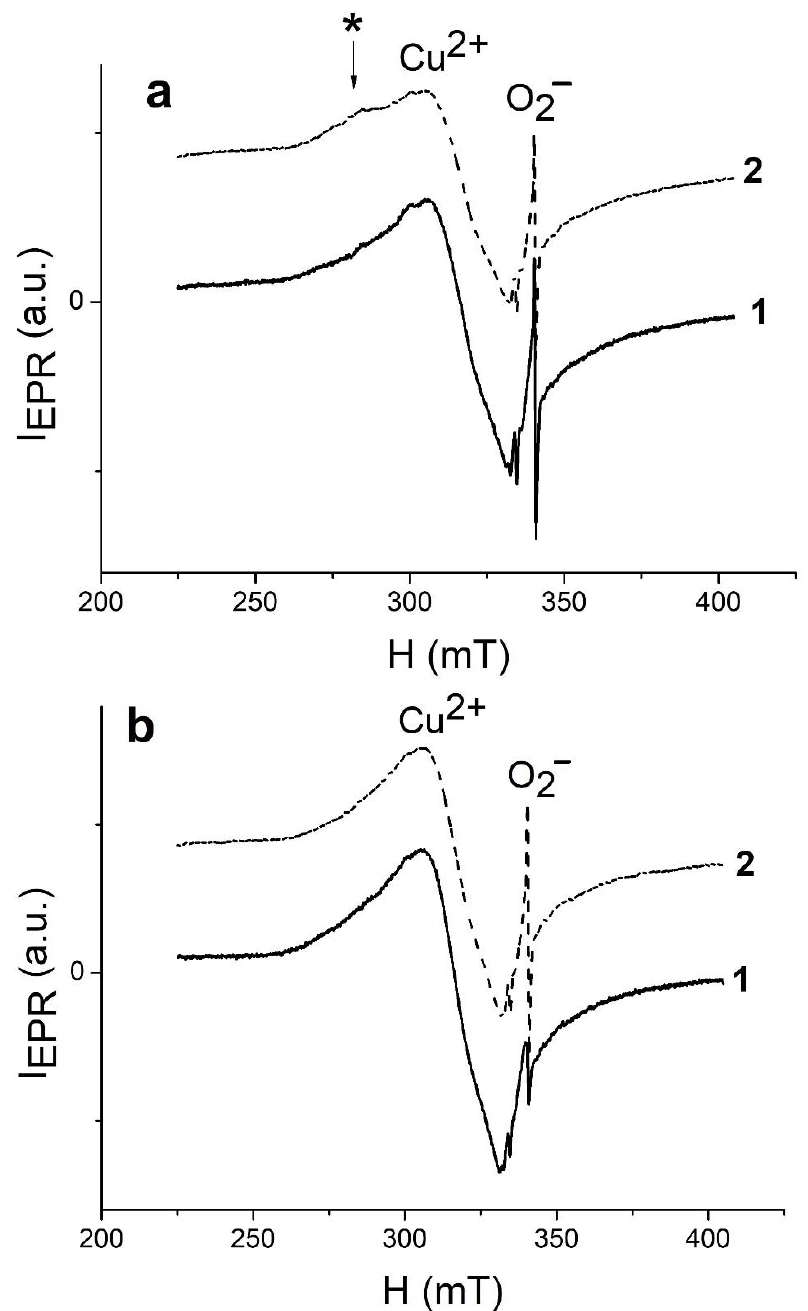
Figure 9. EPR spectra of ( a ) TiO 2 -S-Arg and ( b ) TiO 2 -S-Air samples in the dark (1) and under illumination (2). A “shoulder” of EPR signal marked with a symbol *, corresponds to the Cu 2+ ions embedded in the TiO 2 lattice during synthesis.